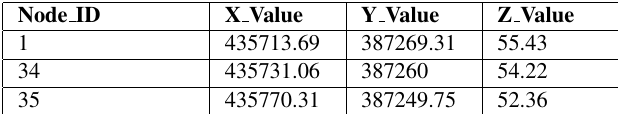
Table 2: Node Table Structure